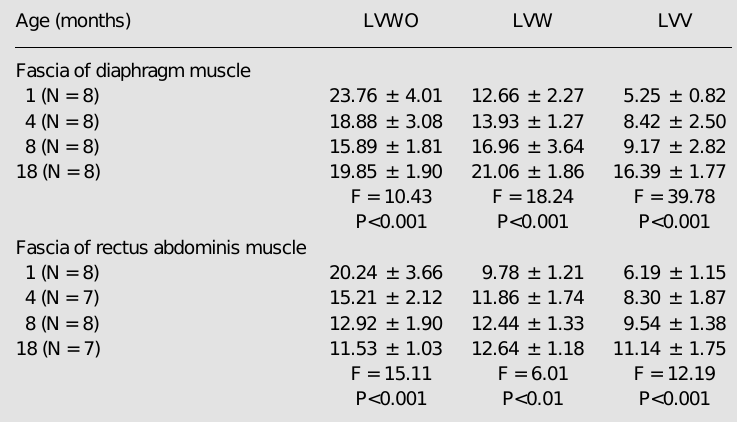
Table 2 - Linear density (LV) of the elastic fiber system. Values of LV are reported as the mean ± SD (x 10 -3 µm -2 ); N, number of rats. For abbreviations, see legend to Table 1. The data on LV of elastic fiber concentration in the tissue were analyzed by ANOVA correlating them with